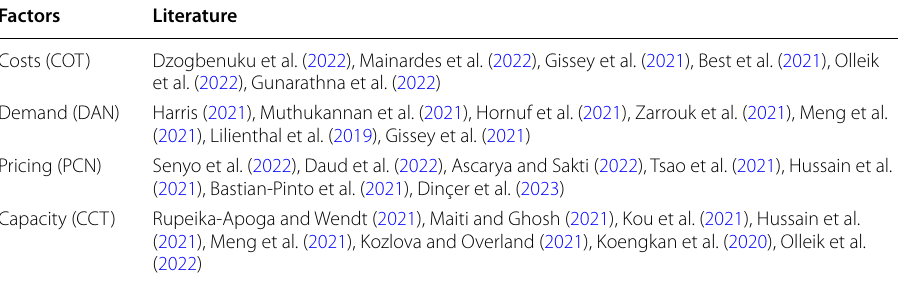
Table 1 Selected criteria for the distributed energy investment necessities